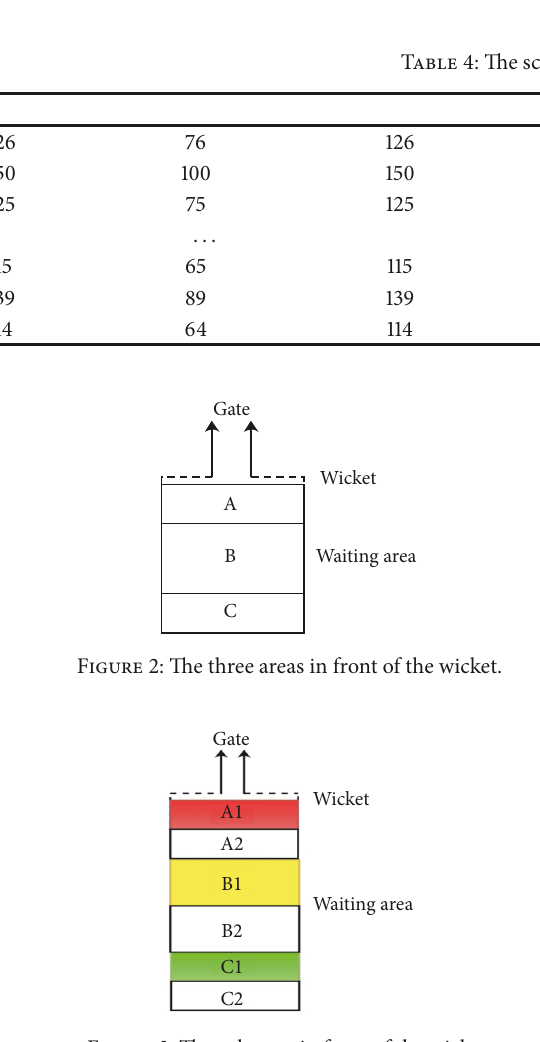
Figure 3: The subareas in front of the